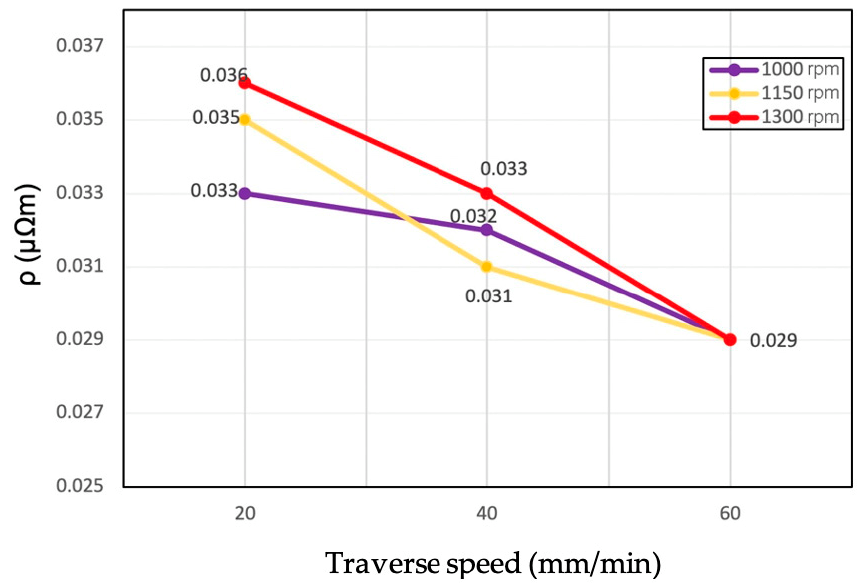
Figure 14. Effect of process parameters on resistivity values of FSW AA 6061-C11000.